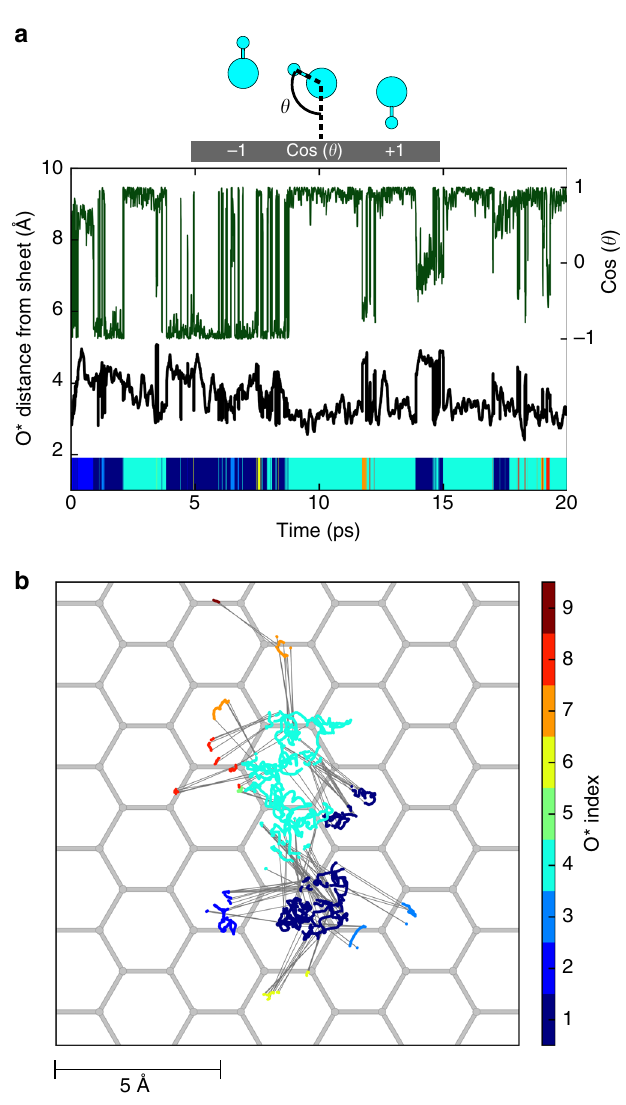
Fig. 3 Unbiased displacements of OH − on graphene. Time variations of the vertical displacement ( a , black curve) and lateral displacement ( b , coloured trajectories) of a free hydroxide starting at the physisorption distance from a graphene sheet. The cosine of the hydroxide orientation with respect to the surface is also plotted vs. time ( a , dark green curve). The index of the hydroxide oxygen O * is associated to a speci fi c colour so that changes of colour represent successive proton transfers in time and hence hydroxide diffusion. Proton transfers are also indicated by thin grey straight lines on top of the carbon hexagonal grid represented in grey ( b )